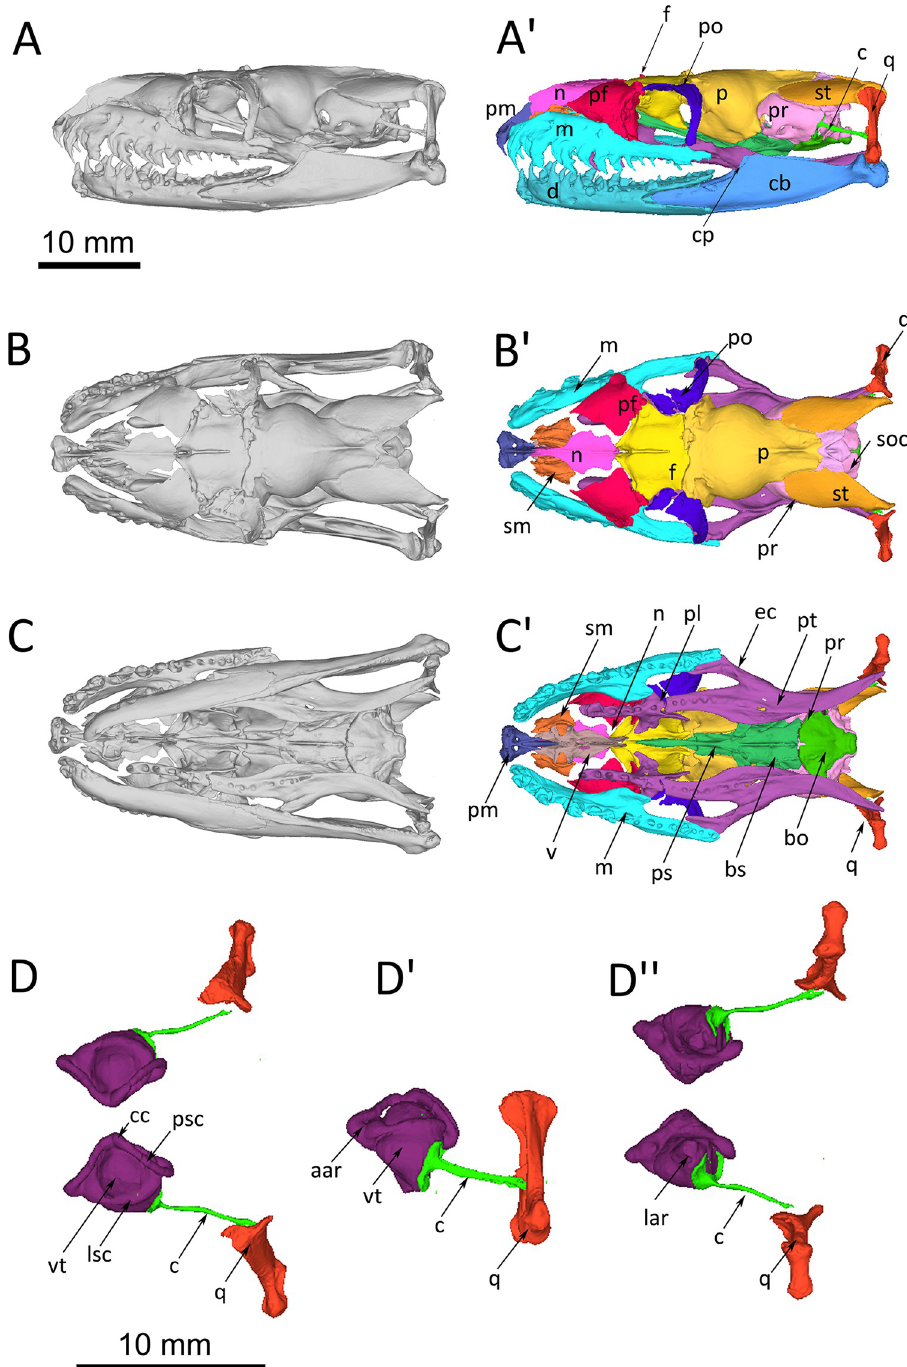
Fig 1. Python regius (# P14), orthographic projections of reconstructions of the complete skull of a wildtype individual based on serial μ CT-images. For all images left is rostral and right is occipital. The inner ear is housed in the prootic bone and supraoccipital bone. Scale bar in (A) for images A-C’; scale bar in (D) for D-D’. (A) Lateral view. (A’) Bones color coded for easy distinction. (B) Dorsal view. (B’) With lower jaw removed, bones color coded for easy distinction. (C) ventral view. (C’) With lower jaw removed, bones color coded for easy distinction. (D) 3D- reconstructed endocasts of the bony inner labyrinth housing the semicircular canals and the sacculus. The columella and the quadrate are elements of the sound transmission apparatus and have been added for orientation. Dorsal (D), lateral (D’) and ventral (D”) view. Abbreviations: aar, anterior ampullar recess; bo, basioccipital; bs, basisphenoid; c,